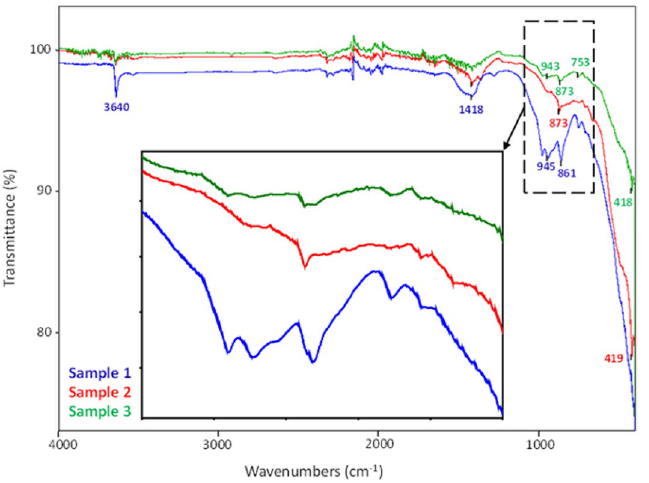
Figure 1. FTIR spectra of slag